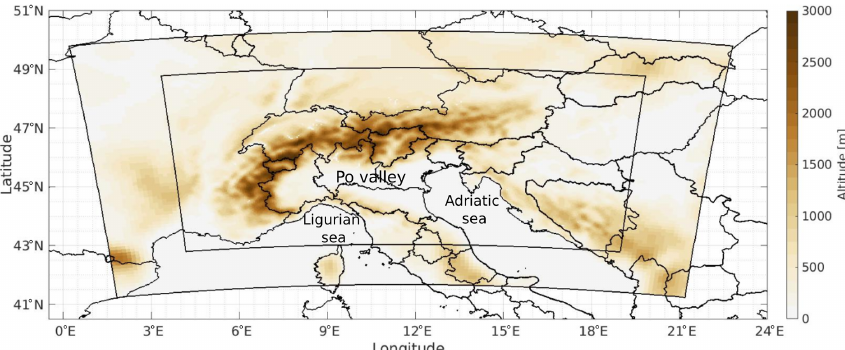
Figure 1. Topography in the two domains used for the 5-year-long runs: outer domain at 12km and inner domain at 4km grid spacing. The three geographical areas of the Ligurian Sea, Adriatic Sea, and Po Valley are labeled in the